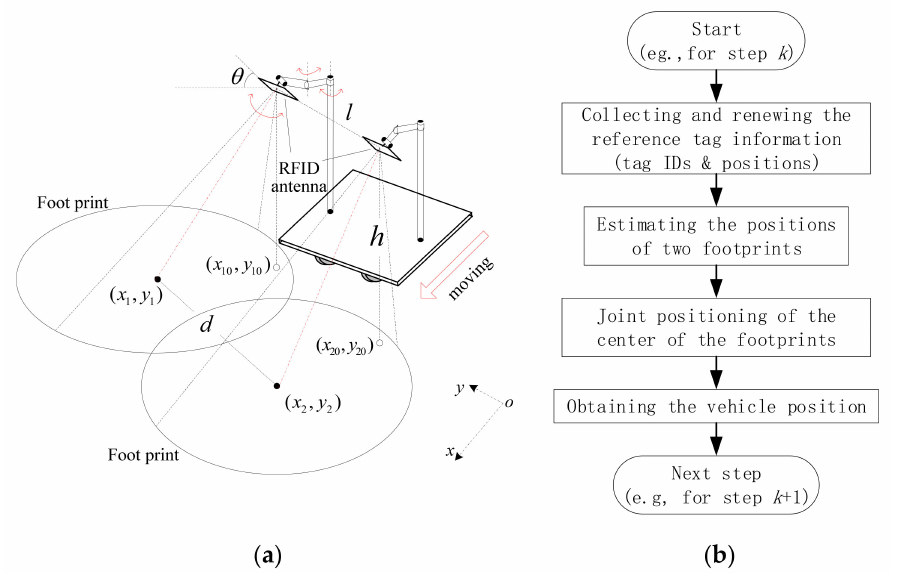
Figure 2. Geometry of the dual-antenna RFID positioning system ( a ) and diagram of the proposed dual-antenna RFID positioning scheme ( b